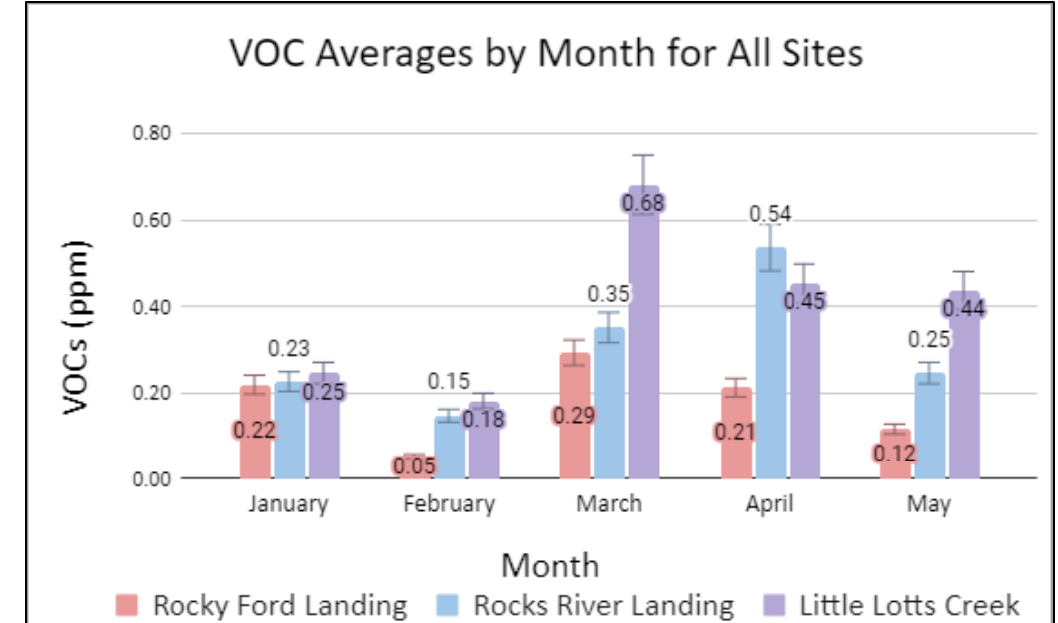
Figure 5. Air Quality — Volatile Organic Compounds (VOCs) Measurements.